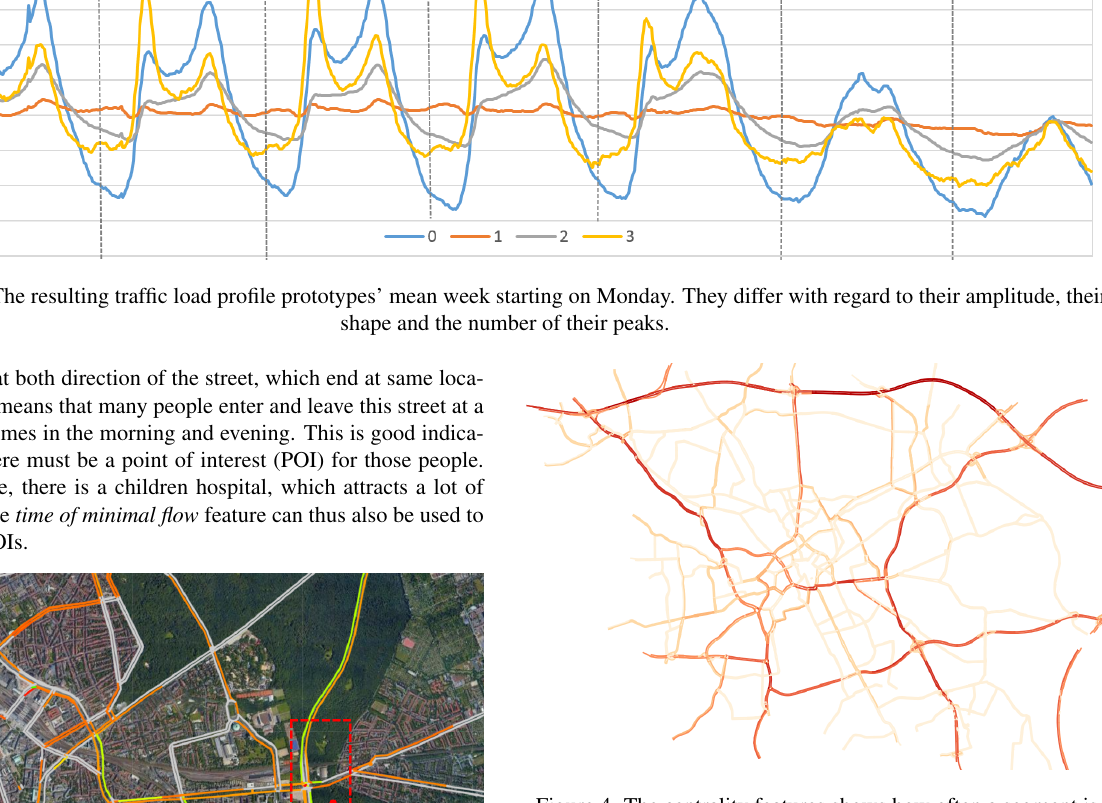
Figure 4. The centrality features shows how often a segment is used in fastest paths (required time considering the length and the speed limit). The intensity of red symbolizes the number of